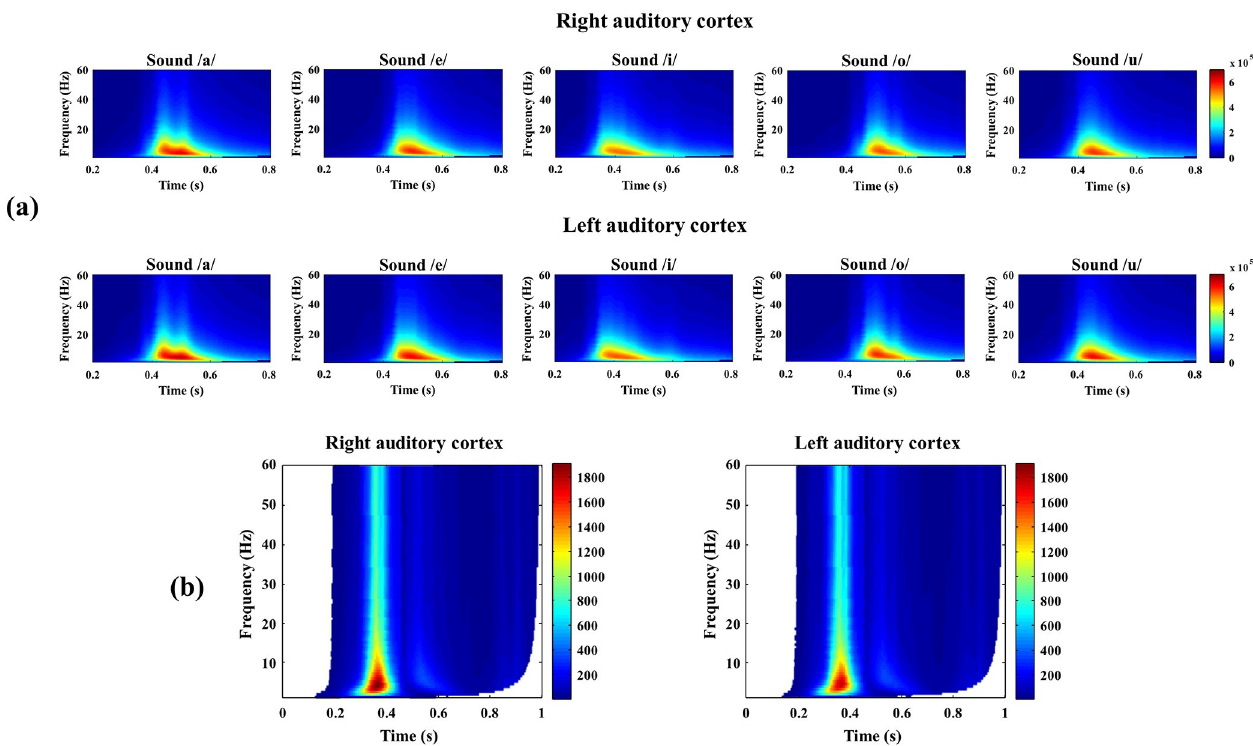
Fig 5. Subject-averaged time-frequency power results. (a) The time-frequency representation (TFR) of the event-related EEG signals (speech stimulation /a/ , /e/, /i/, /o/, or /u/) over all subjects on the right and left anterior auditory fields. TFRs were plotted for the frequency range of 4 to 40 Hz, 0.2 to 0.8 s after each stimulus. One can observe high power activation in the low frequency band (especially in the delta, theta, and alpha band) between 0.3 and 0.6 s regardless of the sound stimulation. (b) Time-frequency regions with significant differences after the Bonferroni correction ( p < 0.01 on the ANOVA test) are plotted. The color scale represents the F-values and non-significant regions are colored in white. Note that most of the brain responses between 0.2 and 0.8 s after the stimuli showed distinct neural responses across each vowel sound.